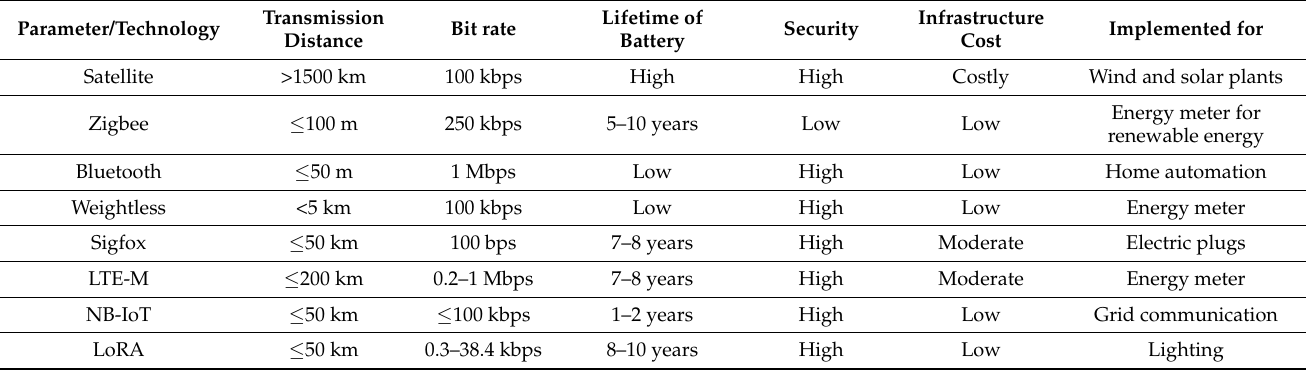
Table 2. Technical specifications of distinct wireless communication technologies